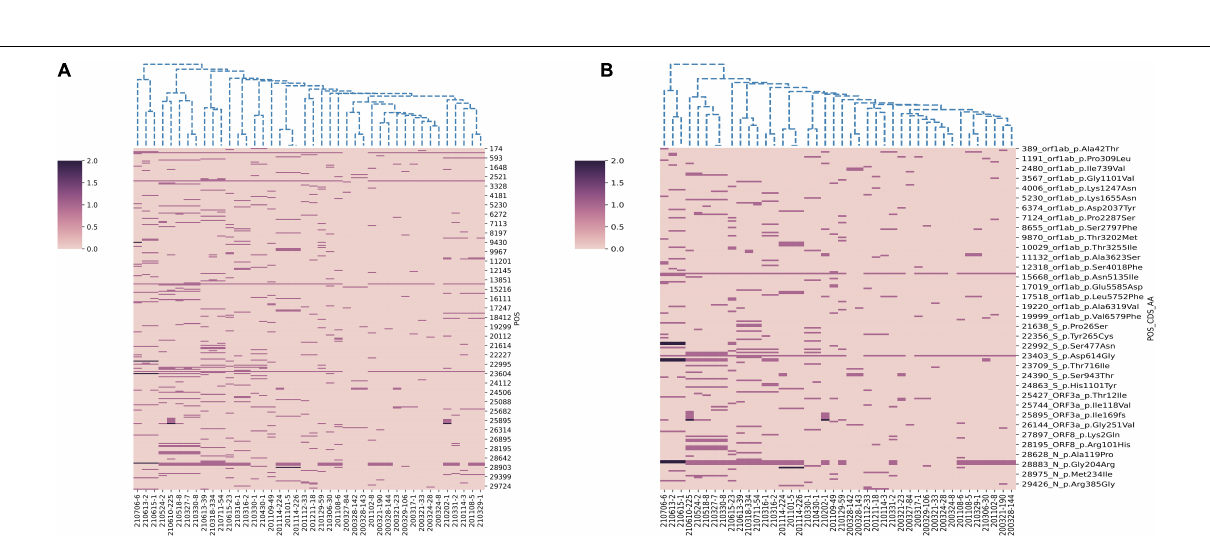
FIGURE 2 | Hierarchical clustering of nucleotide and amino acid mutations in 42 SARS-CoV-2 genomes. (A) The nucleotide mutations sites. (B) The amino acid mutations sites. The reference genome is Wuhan-Hu-1 (GenBank Accession No: MN908947.3). A color scale indicates the numbers of mutation sites in each genome, from lowest (pink) to highest